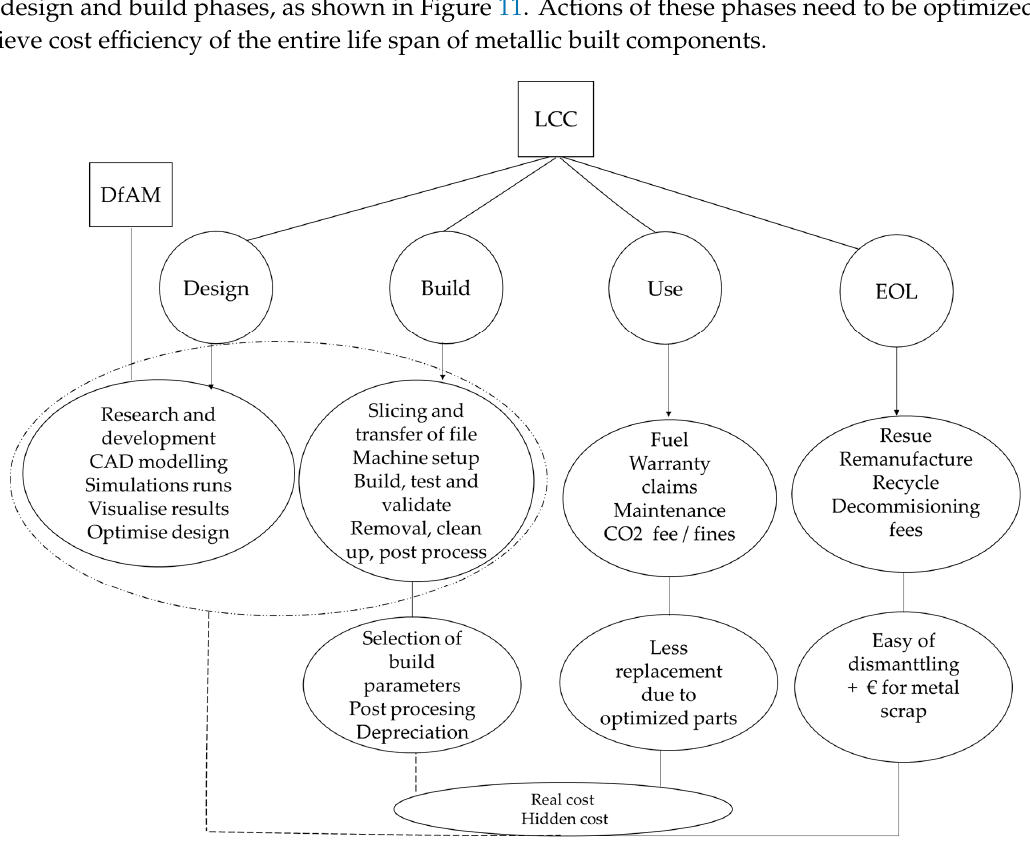
Figure 11. Schematic of activity-based cost structure breakdown for L-PBF of metallic components.